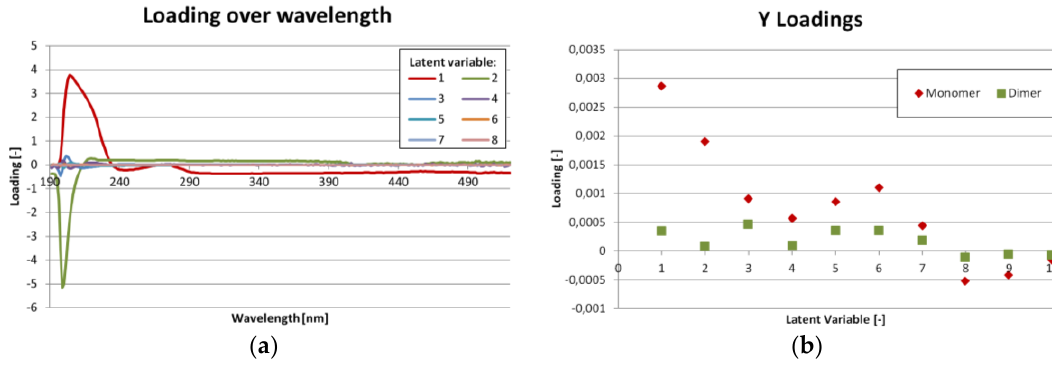
Figure 6. ( a ) Loading over wavelength diagram for the first eight latent variables. The higher the absolute value, the more important is this wavelength for the latent variable; ( b ) loadings of the Y results over latent variables. The higher the absolute value, the higher is the importance of this latent variable for the concentration calculation of monomer or dimer respectively.